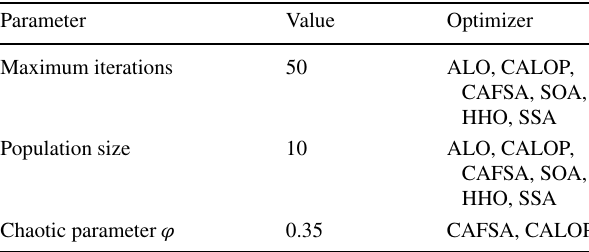
Table 5 Parameter settings for different optimization